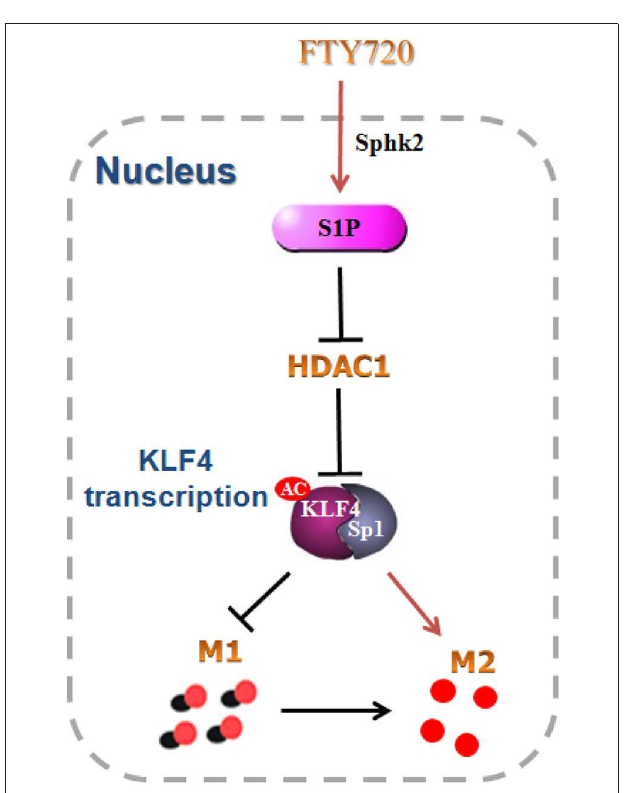
FIGURE 7 | Schematic model. FTY720 was phosphorylated to S1P by intra-nuclear Sphk2, and subsequently inhibited KLF4 interaction with HDAC1 and promoted the acetylation of KLF4. The acetylated KLF4 facilitated the switch of microglial polarization from M1 to M2 phenotype. All data are presented as means ±